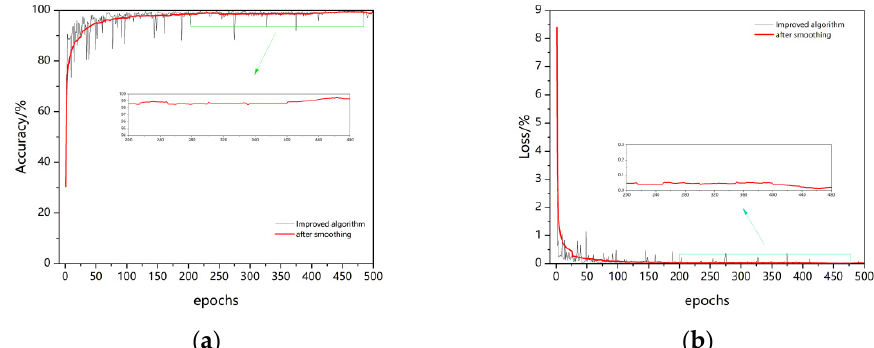
Figure 10. The training curve of the improved algorithm on the GDX-ray dataset. ( a ) The recognition accuracy curve. ( b ) The loss value curve.